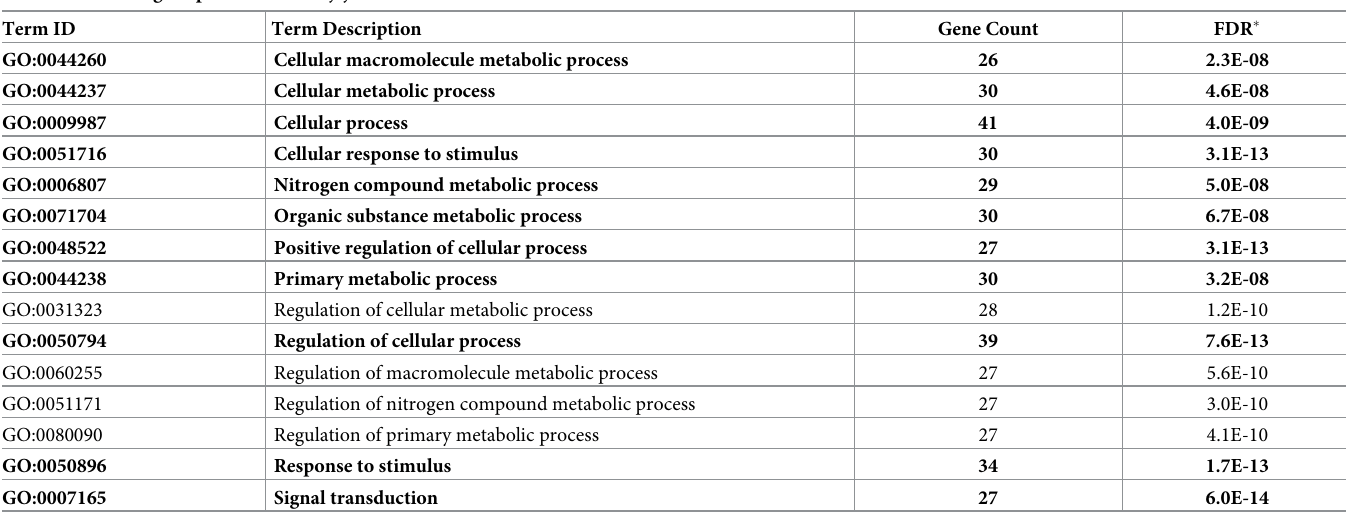
Table 2. GO biological processes in the jejunum.